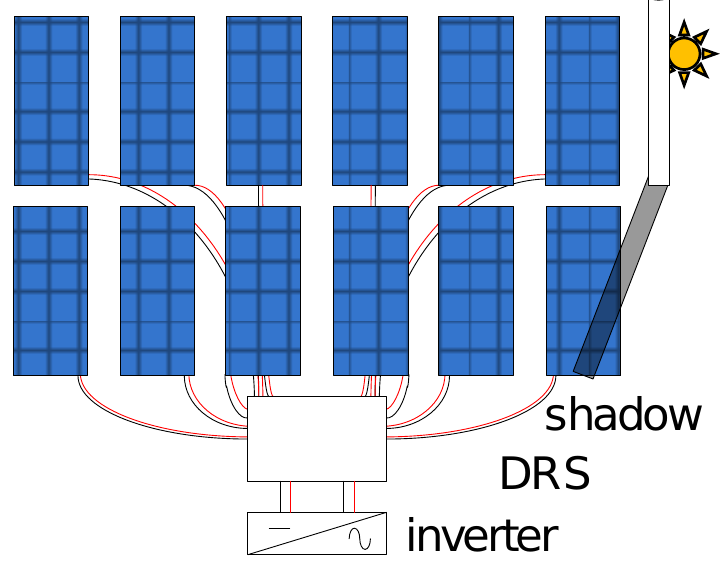
Figure 6. DRS in a PV plant.